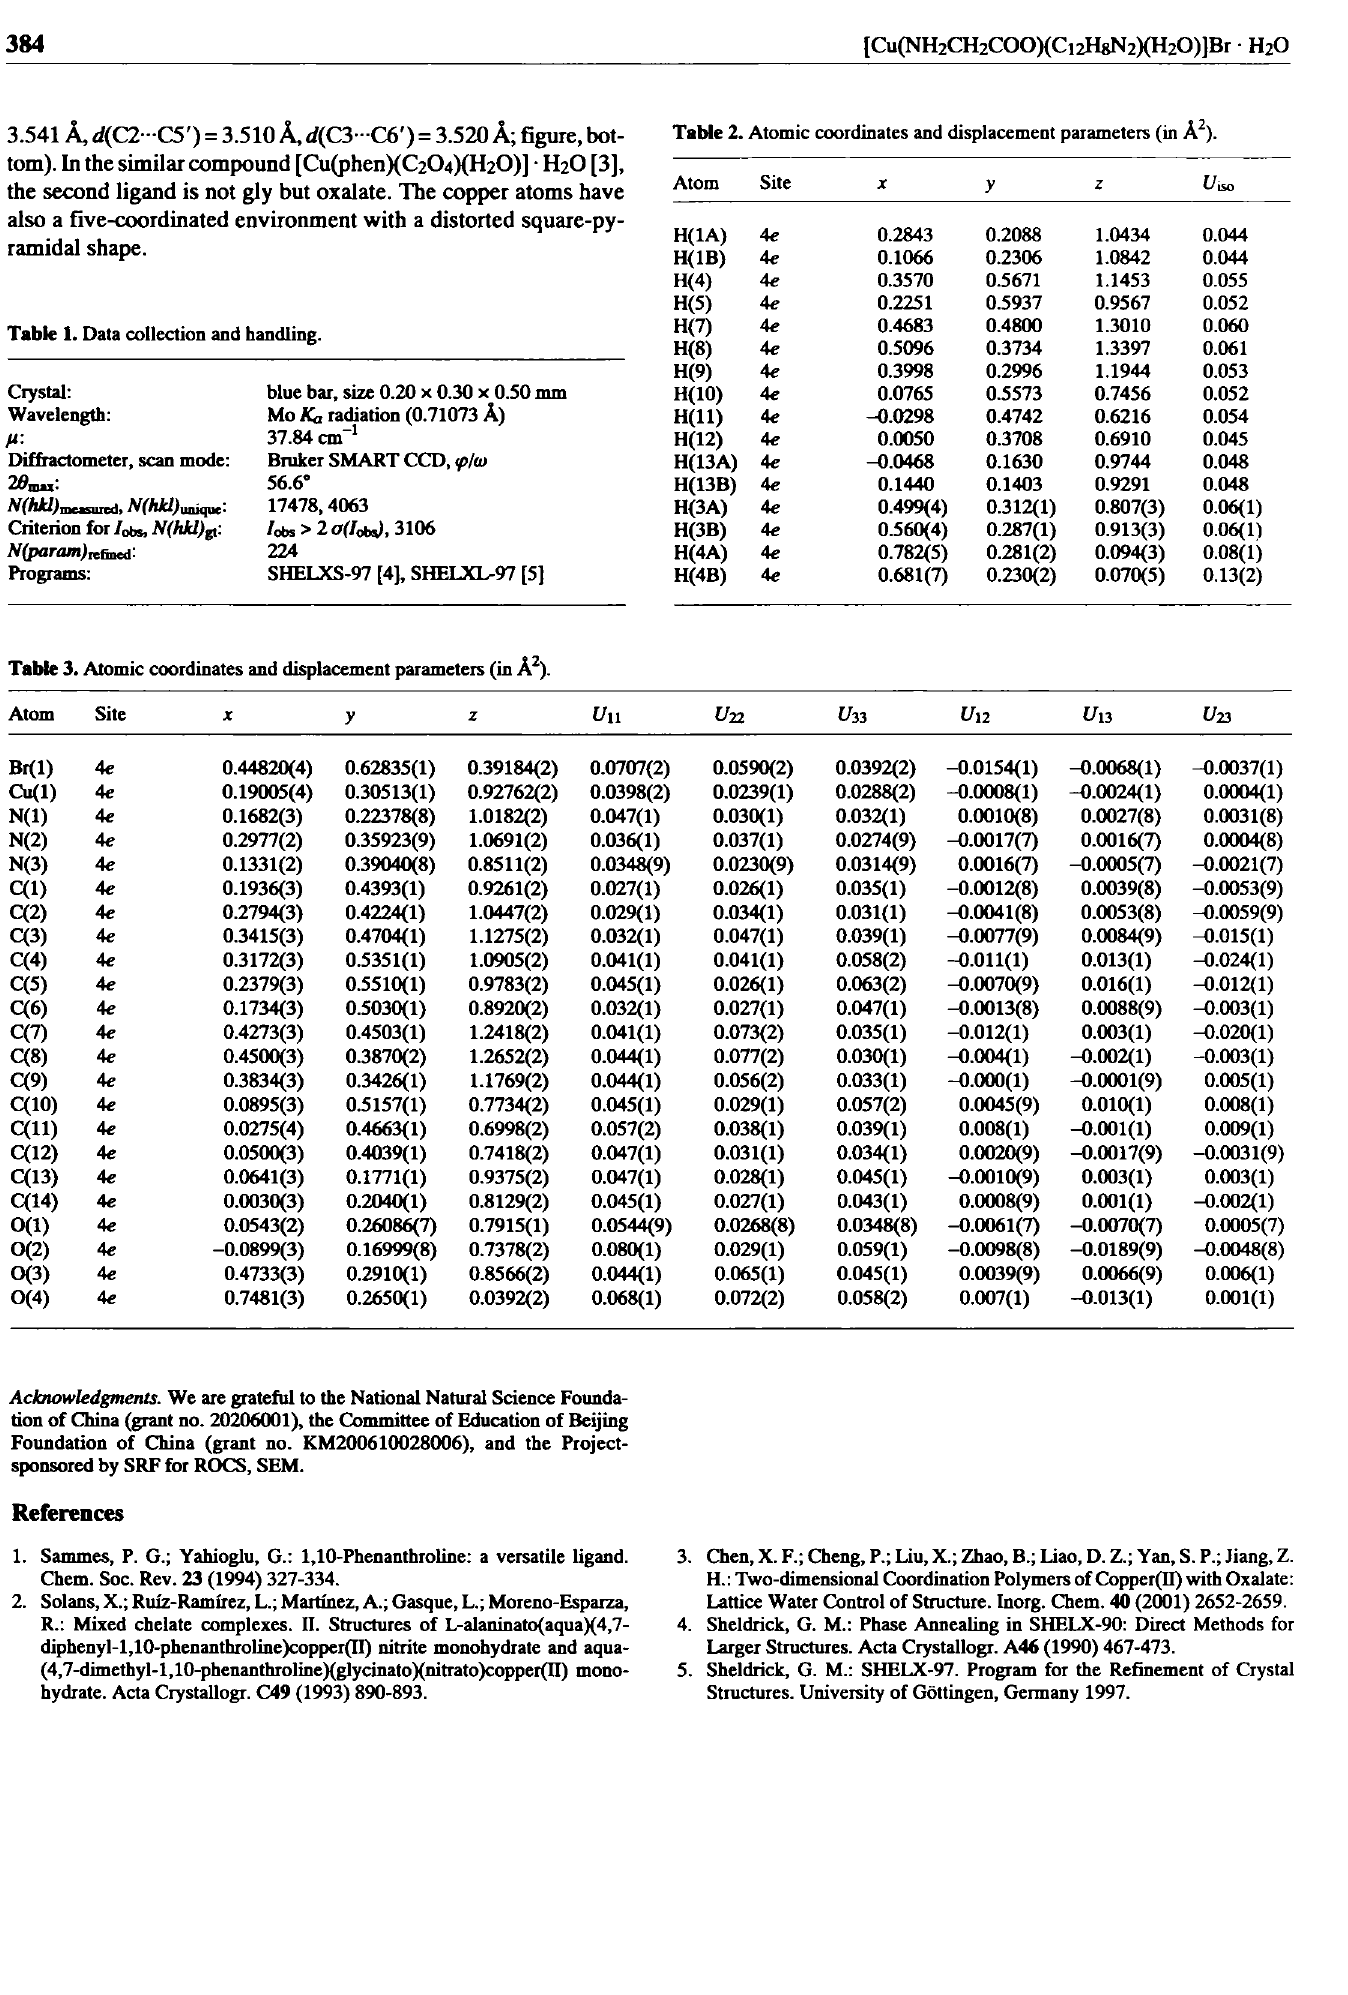
Table 1. Data collection and handling.